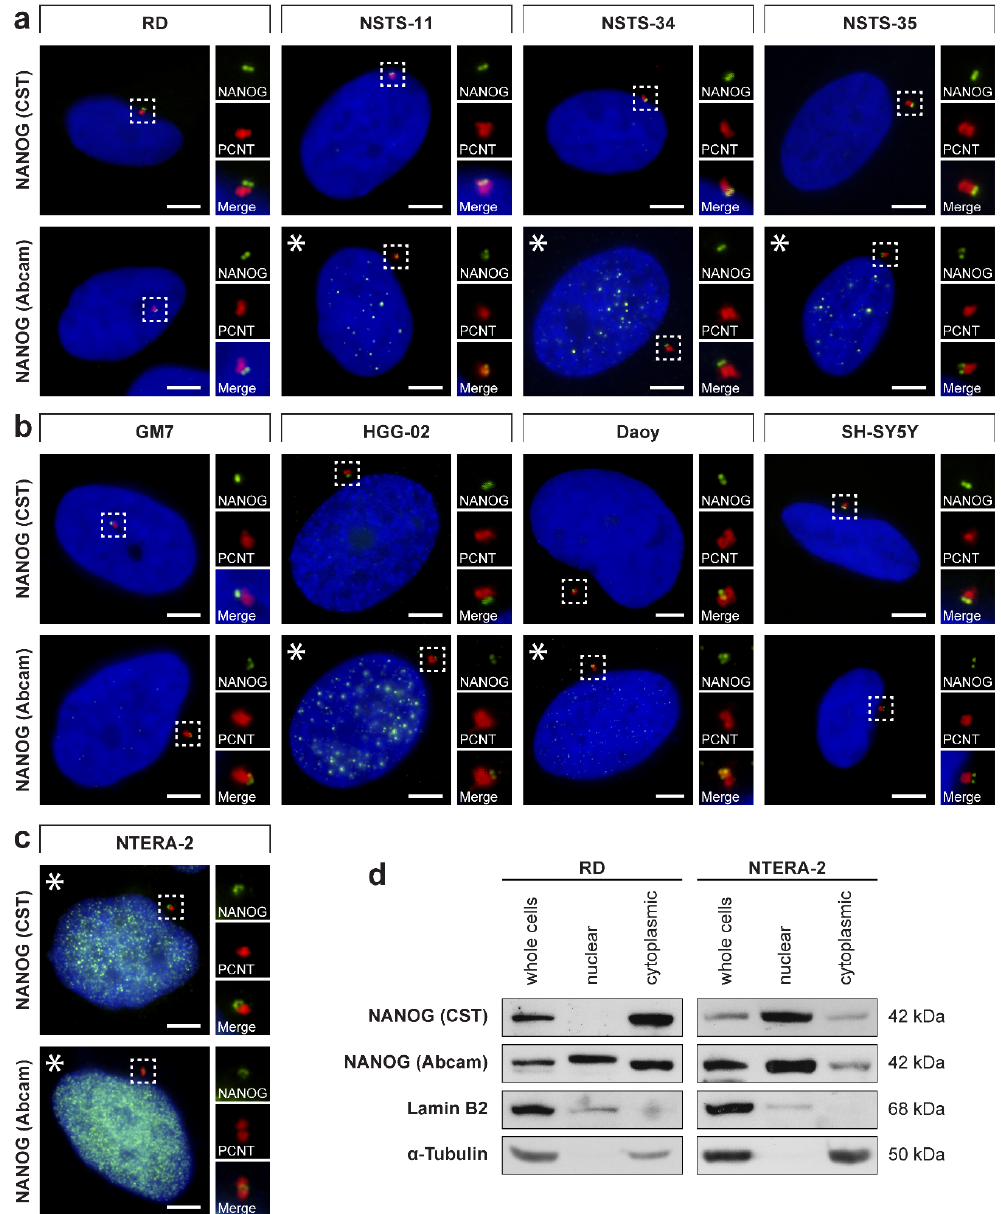
Figure 3. Centrosomal localization of NANOG in tumor cell lines and Western blotting of the nuclear and cytoplasmic fractions. The centrosomal localization of NANOG (green) was detected in ( a ) rhabdomyosarcoma cell lines, ( b ) cell lines of neurogenic origin, and ( c ) NTERA-2 pluripotent embryonal carcinoma cell line using two anti-NANOG antibodies (#4903, Cell Signaling Technology (CST) and #ab109250, Abcam) and anti-pericentrin antibody (PCNT; red). NANOG was also detected in the cell nucleus in the NTERA-2 cell line and some other tumor cell lines (indicated by asterisks). The nuclei were counterstained with Hoechst 33342 (blue). For each image, a region of interest is indicated by the dashed box, and the respective close-ups are provided on the right. Scale bars, 5 μ m. ( d ) Western blot analysis revealed the presence of a substantial pool of cytoplasmic NANOG in both RD and NTERA-2 cell lines. Nuclear/cytoplasmic fractionation followed by immunoblotting was performed using two independent anti-NANOG commercial antibodies (#4903, Cell Signaling Technology (CST) and #ab109250, Abcam). Lamin B2 and α -tubulin served as controls of the nuclear fraction and cytoplasmic fraction purity, respectively. Western blots of biological replicates are provided in Figure